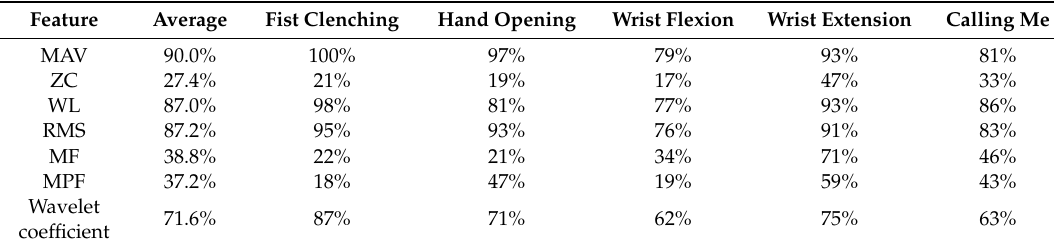
Table 1. Classification accuracy of 5 actions (fist clenching, hand opening, wrist flexion, wrist extension, and calling me) based on single feature (MAV, ZC, WL, RMS, MF, MPF, and wavelet coe ffi cient). The purpose of this table is to explore the optimal feature among all features selected. Each row represents the accuracy of di ff erent actions based on a single feature. Each column represents the accuracy of a single action based on di ff erent features. We also calculated the average accuracy to make a better comprehensive comparison.